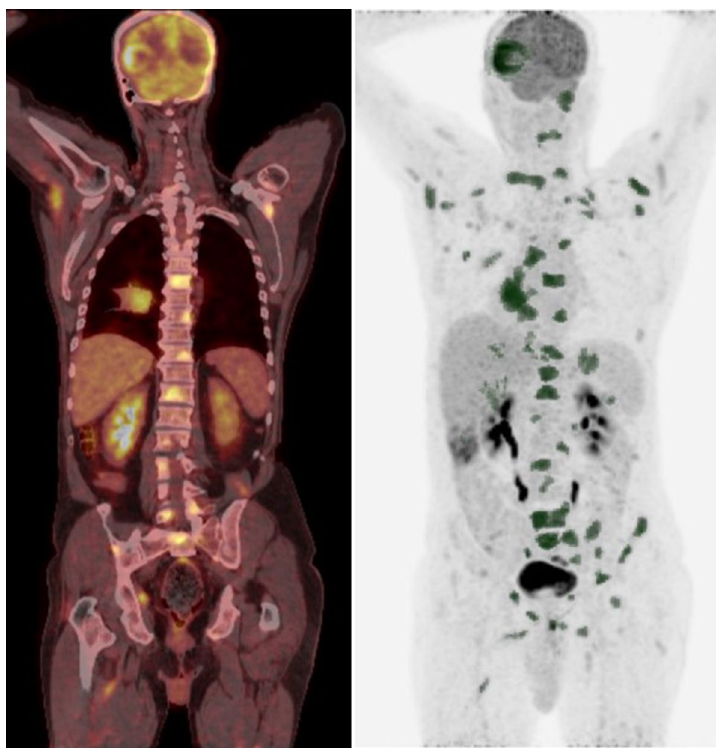
Fig. 2 Representative 18 F-FDG PET/CT MIP and coronal images for a patient with a high whole-body tumor burden (WBTB). A 61-year- old male patient with pathologically proven right lower lobe NSCLC, adenocarcinoma. FDG uptake was abnormally increased at the primary tumor mass as well as multiple metastatic nodal, osseous brain, and muscular deposits, corresponding SUVmax, SUVpeak, SUVmean, tu MTV, tu TLG, WB MTV, and WB TLG 4.9, 4.2, 2.9, 33, 96.03, 317.53, 931.88,